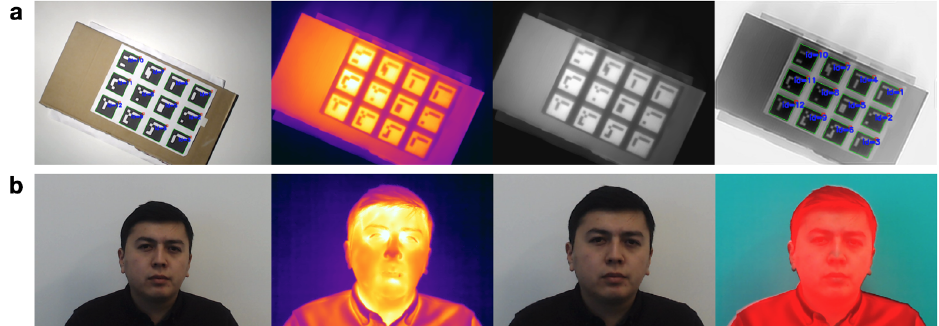
Figure 6. ( a ) Left to right: the visual image with identified ArUco markers; the original thermal image; a grayscale version of the thermal image; and a complement of the grayscale image with identified ArUco markers. ( b ) Left to right: the original visual image; the original thermal image; the result of aligning the visual image with it’s thermal pair; and the result of replacing the red channel of the visual image with the red channel of the thermal image.